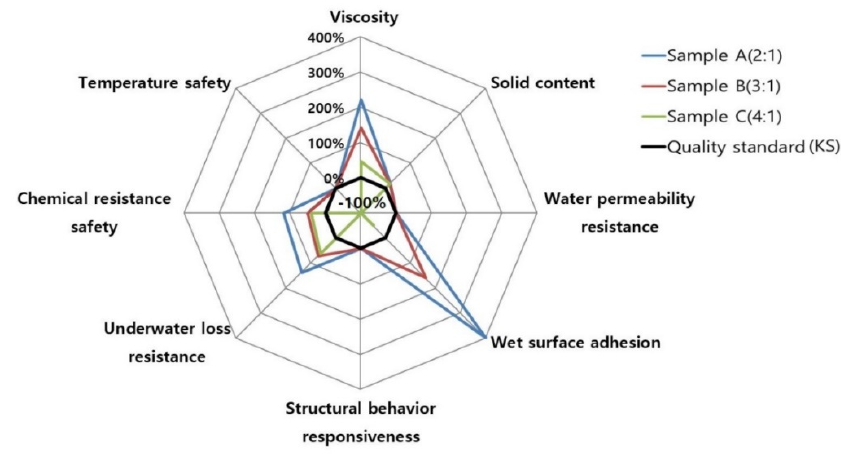
Figure 13. Comparison of performance improvement by sample of W-SPRG compared to KS quality standard.